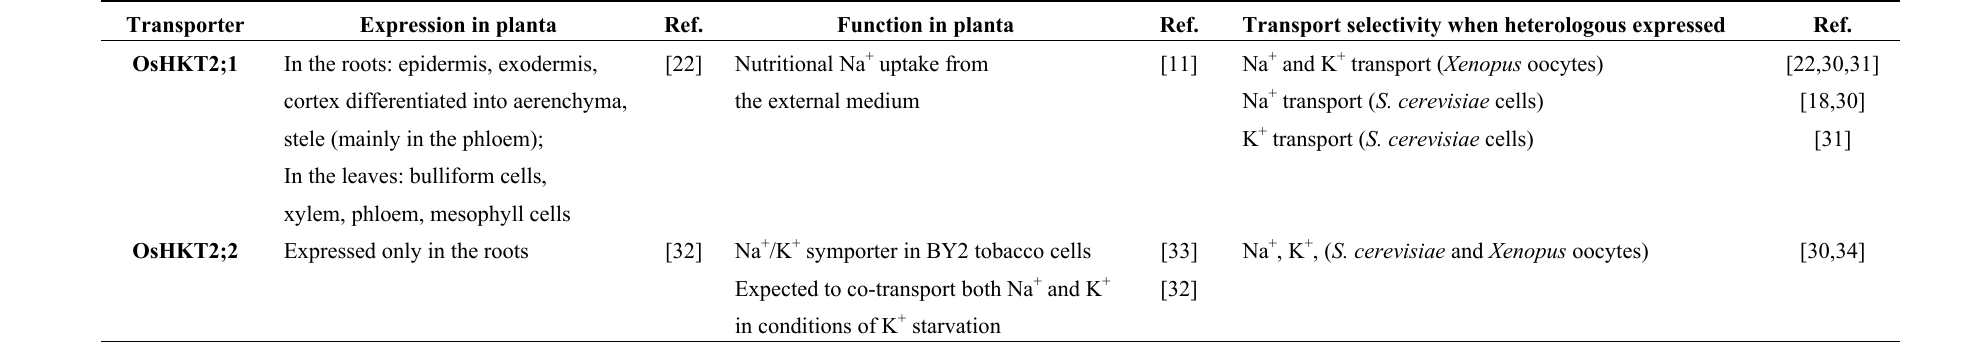
Table 2. List of all HKT2 transporters isolated and